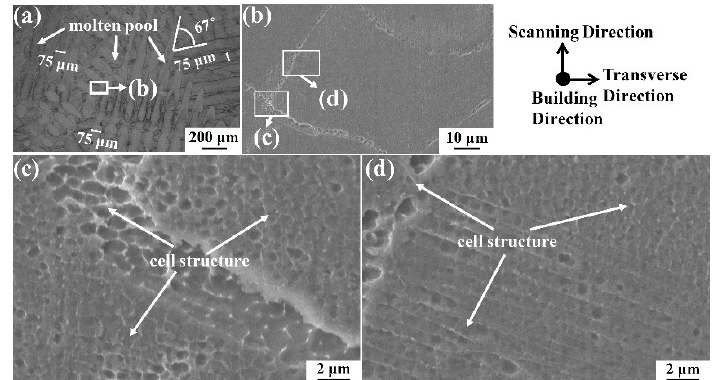
Figure 5. ( a ) Optical micrograph and ( b ) SEM (scanning electron microscope) micrograph of the 316L stainless steel bulk fabricated via SLM revealing the morphology of molten pool. ( c ) ( d ) SEM micrographs showing the observed cell structure can be formed at the boundary of the molten pool and other areas. Two kinds of substructures consist of cell structures: strip-like substructures and spherical substructures.